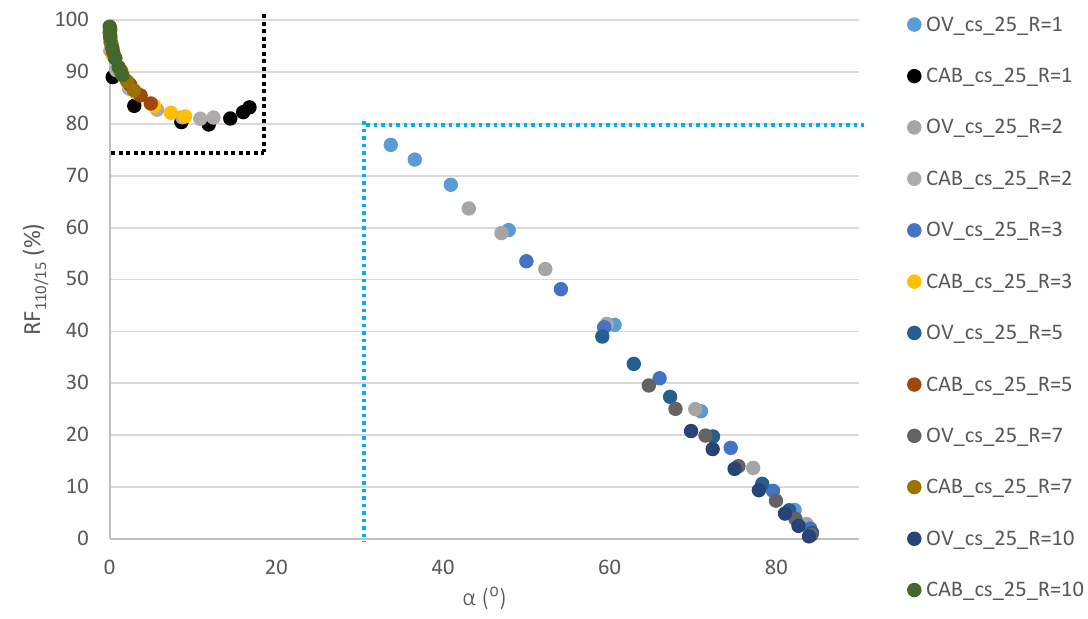
Figure 19. RF 110/15 / α characteristic. Figure 19. RF 110 / 15 / α